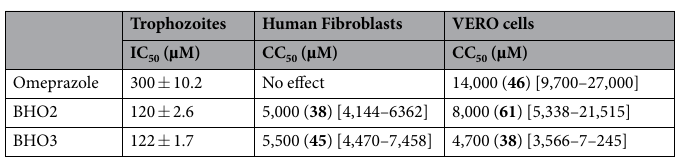
Table 2. Cytotoxicity test of compounds. The IC 50 values ± standard error from trophozoites were obtained from graphs depicted in Fig. 6. The CC 50 values of mammal cells cultures were obtained as described under material and methods section. The numbers inside of parenthesis correspond to the ratio CC 50 /IC 50 values between mammal cells and trophozoites. The numbers inside of squares parenthesis indicate de 95% confidence